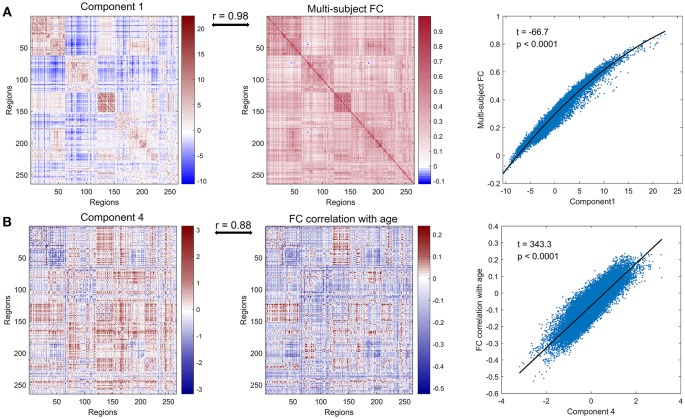
Further analysis of principal component 1 and principal component 4. (A) PC 1 (left panel), multi-subject matrix by calculating correlations across the concatenated time series of all subjects (middle panel) and the quadratic association between values of PC 1 (x-axis) and values of multi-subject matrix (y-axis) (right panel). PC 1 and multi-subject matrix are highly correlated (r = 0.98). (B) PC 4 (left panel), the matrix of age effects on edges by computing the correlation between age and functional connectivity for each edge (middle panel) and the linear association between values of PC 4 (x-axis) and values of age-effect matrix (y-axis) (right panel). PC 4 and age-effect matrix are highly correlated (r = 0.88).